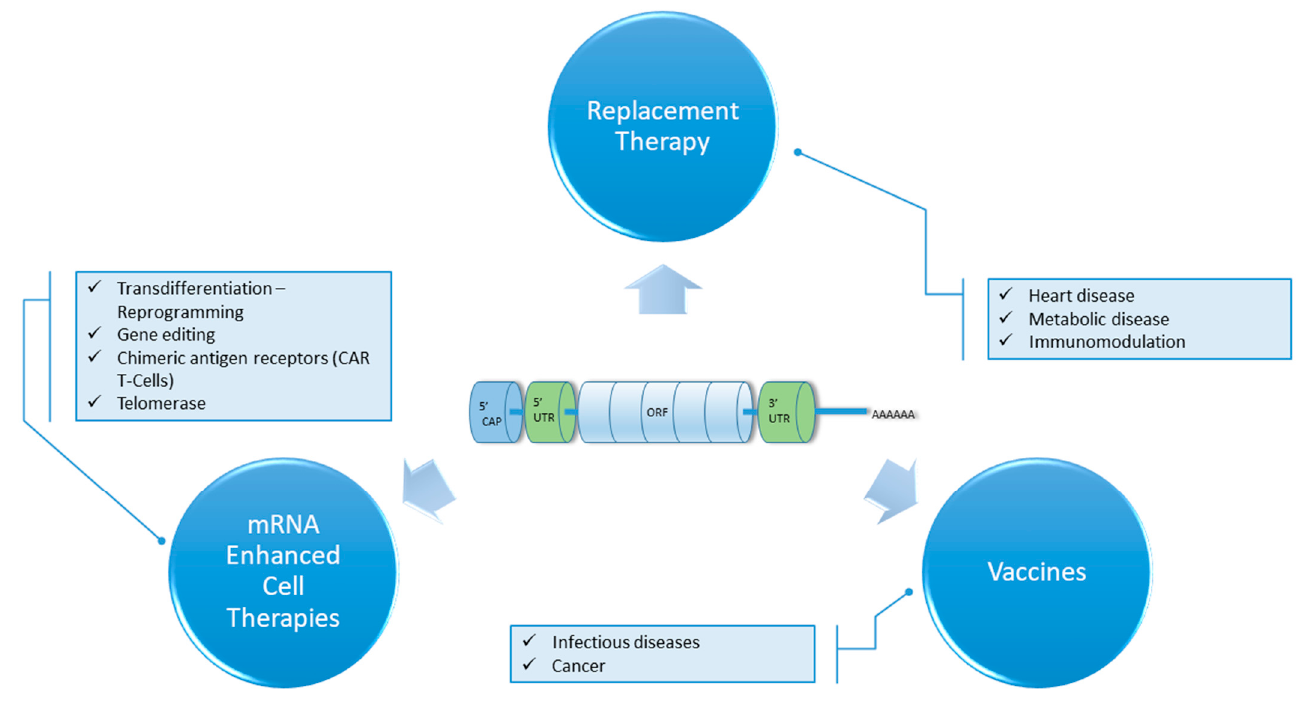
Figure 1. Main applications of mRNA in therapeutics broken down in the three major categories of replacement therapy, cell therapies and